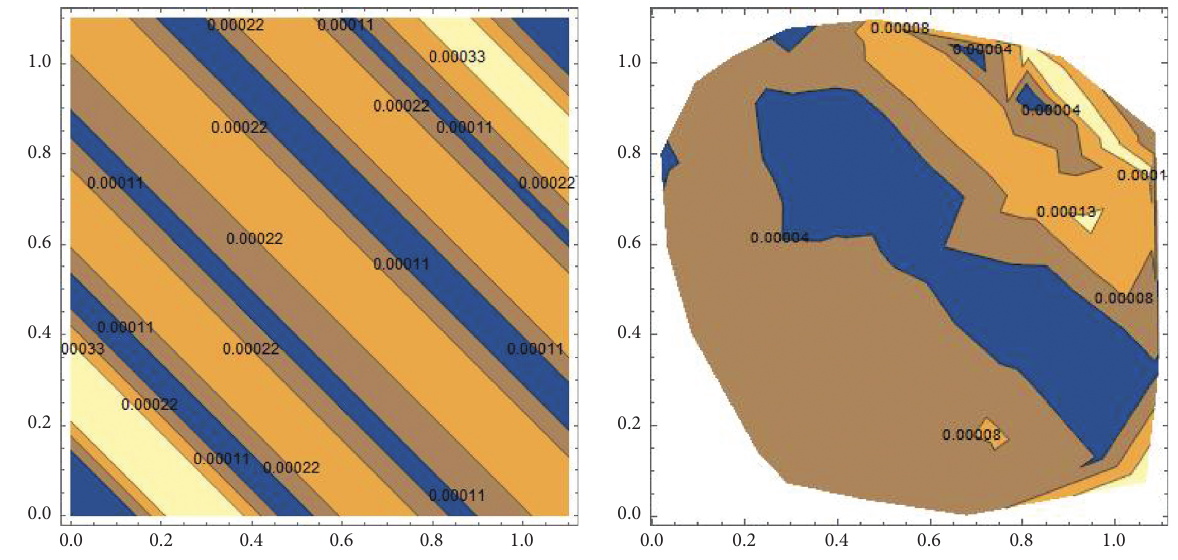
Figure 12: Contour plot errors for the same points. Table 4: Accuracy of RBF to Fredholm linear two-dimensional integral equation for mesh and meshless points. N E